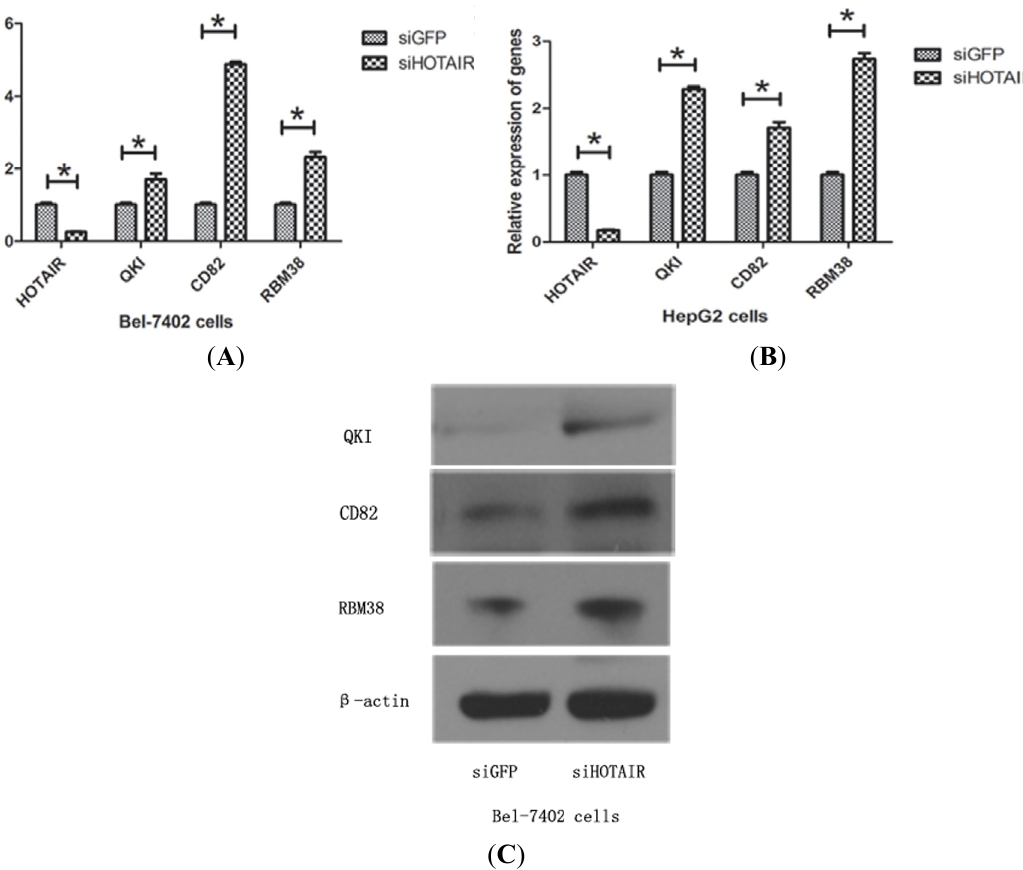
Figure 3. Upregulation of QKI, CD82, and RBM38 were validated after knockdown of HOTAIR . ( A ) Bel-7402 cells; ( B ) HepG2 cells were transiently transfected with HOTAIR siRNA for 48 h to detect QKI, CD82, and RBM38 expression by qRT-PCR compared with the siGFP group ( * indicated p < 0.05); and ( C ) showed the protein level of QKI, CD82, and RBM38 after HOTAIR knockdown in Bel-7402 cells by Western blot. All experiments were performed in